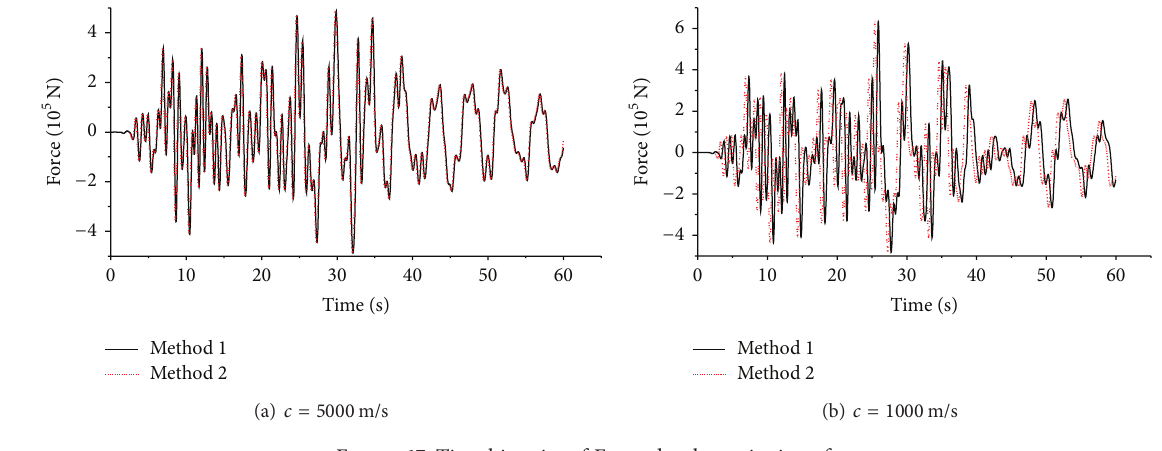
Figure 17: Time histories of 𝐹 𝑃2 under the excitation of 𝑐 3 .